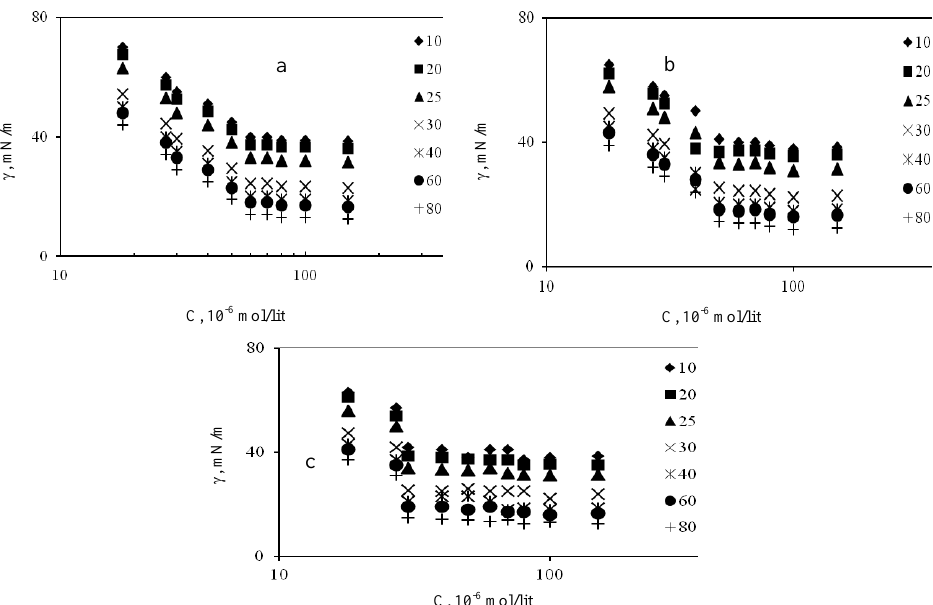
Figure 1. The variation of surface tension as a function of surfactant concentration in aqueous solution (a) Polysorbate-20 (b) Polysorbate-40 and (c) Polysorbate-80 at different temperatures (10-80 o C).